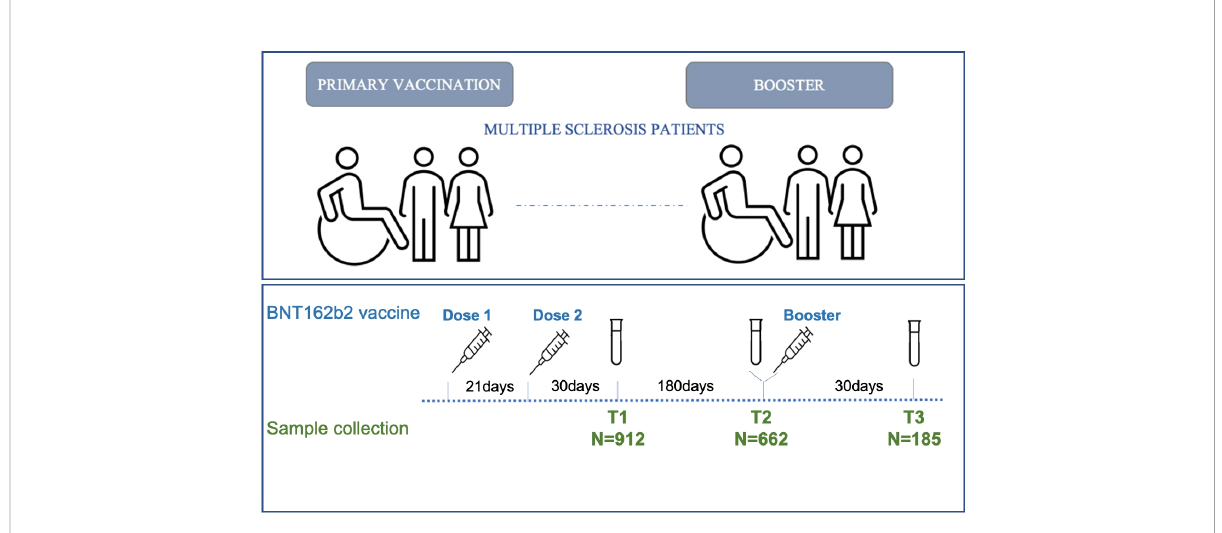
FIGURE 1 Timeline of MS patients ’ enrollment. Schematic of the vaccination (blue) and sample collection (green) timeline in MS